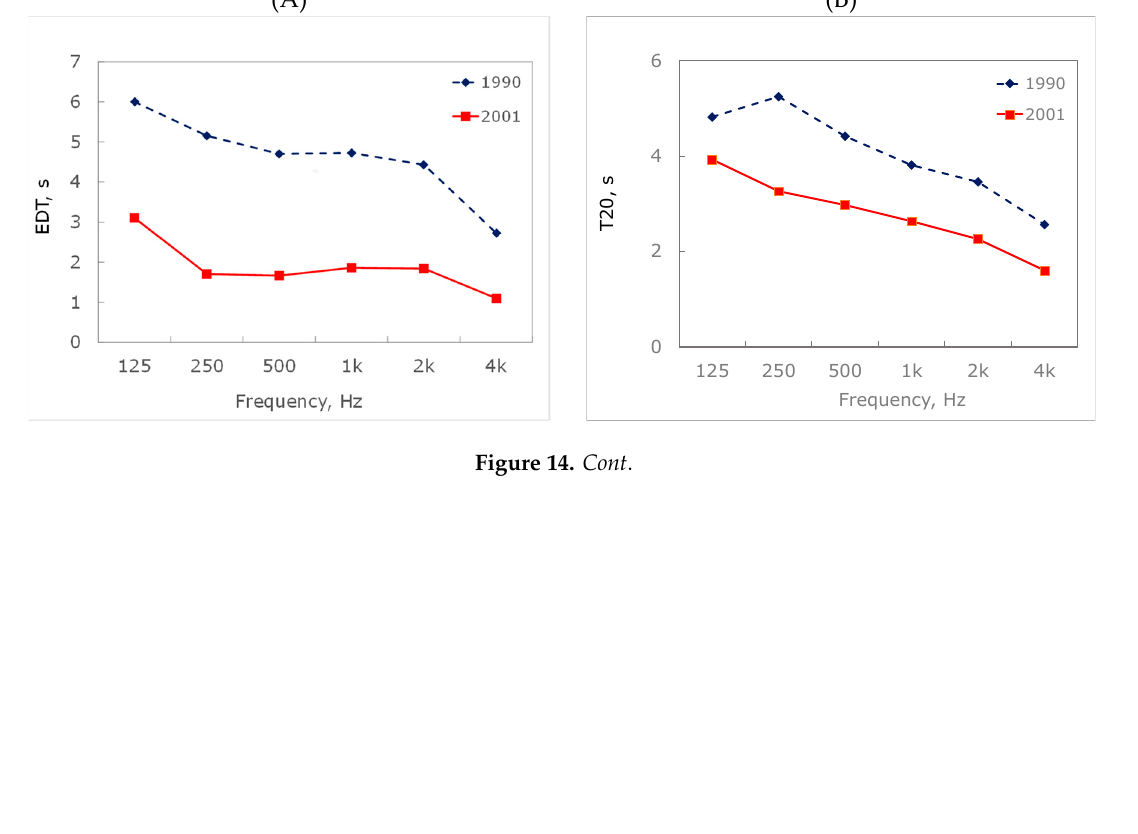
Figure 13. Transparent panel closing the arch dividing the transept area from the nave.